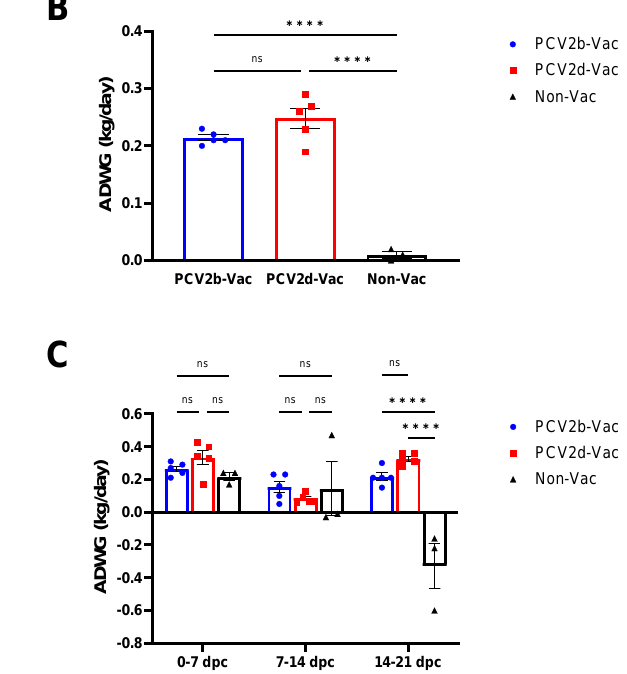
Figure 5. Growth performance of vaccinated and nonvaccinated pigs in the vaccine efficacy study (Experiment 2). The average daily weight gain (ADWG) was calculated during three experimental periods: vaccination to PCV2d challenge (0–21 dpv, 21 days) ( A ), PCV2d challenge to necropsy (0–21 dpc, 21 days) ( B ), and each week after PCV2d challenge (0–7 dpc, 7–14 dpc, and 14–21 dpc) ( C ). All data are presented as group means ± SEM. Statistically significant differences are indicated at p < 0.0001 (****).